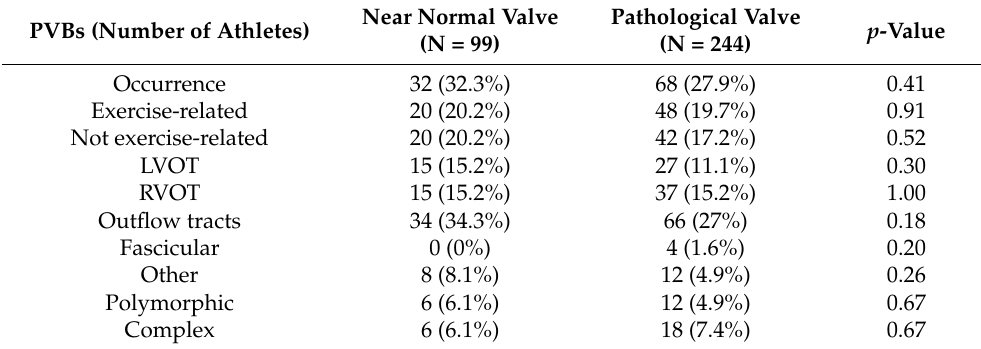
Table 3. PVBs’ rate of occurrence, relationship with exertion, morphology, number of morphologies and complexity comparison between near normal valve BAV and pathological valve BAV.